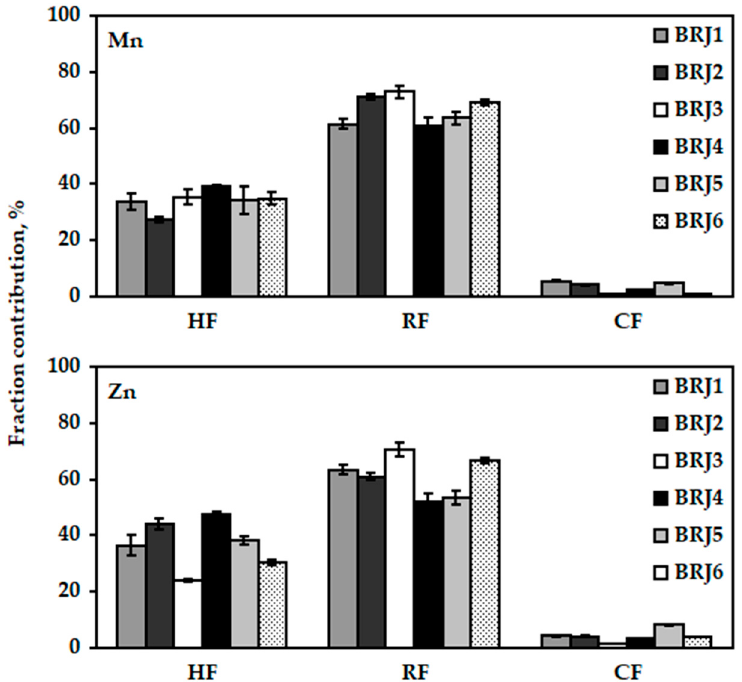
Figure 2. The contributions of the chemical fractions of the Mn and Zn species, i.e., the hydrophobic (HF), the residual (RF) and the cationic (CF), determined in the selected beetroot juices (BRJ1 − BRJ6) using the two-column solid-phase extraction (SPE) with the LC-18 and LC-SCX tubes. The contributions of the RF of Cu, Fe, Mn, and Zn, which likely contained the negatively charged or neutral complexes of these metals, not sufficiently hydrophobic to be retained by the LC-18 SPE